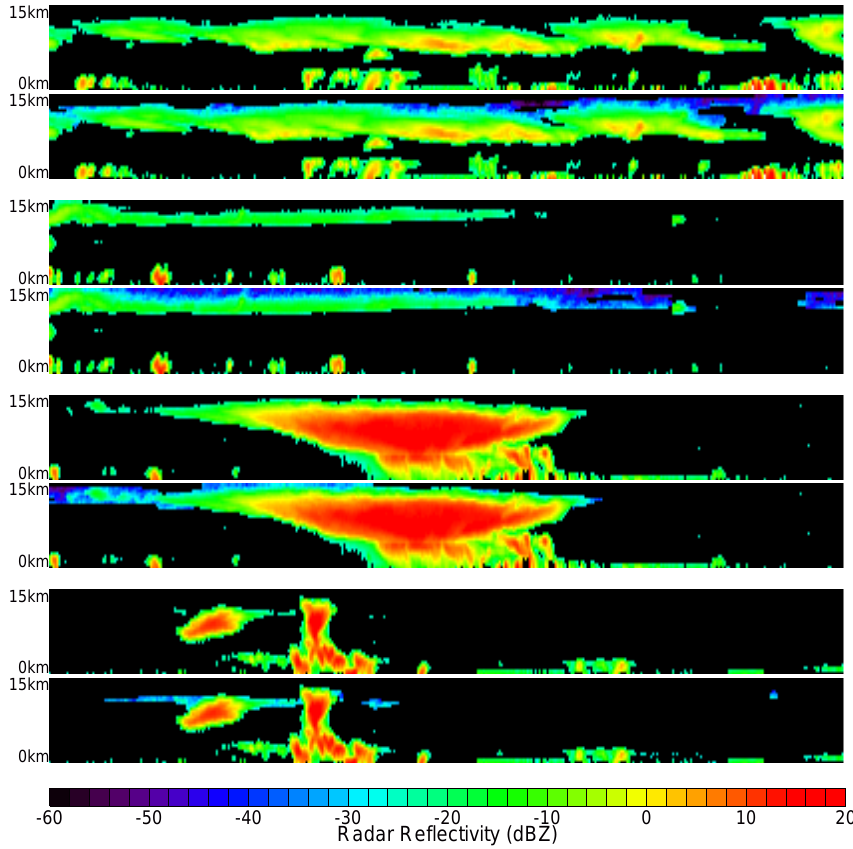
Fig. 2. An example of the stochastic simulation of radar reflectivity for lidar identified cloudy layers with CloudSat reflectivity below − 26dBZ. For each pair of radar profiles, the top strip uses a − 26dBZ threshold without simulated reflectivity and the bottom strip includes the simulated reflectivity. There are 1600 CloudSat columns from two separate orbits over the TC4 region. The layers in this example are all 0.5km